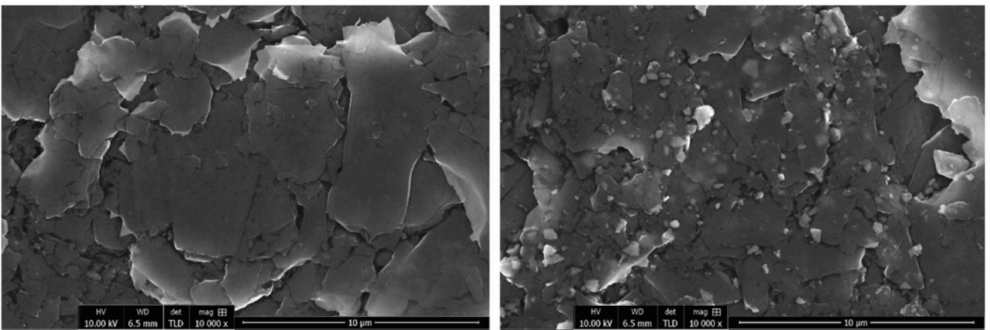
Figure 2. SEM images of graphene paste electrode ( left ) and clay paste electrode ( right ), 10,000 ×